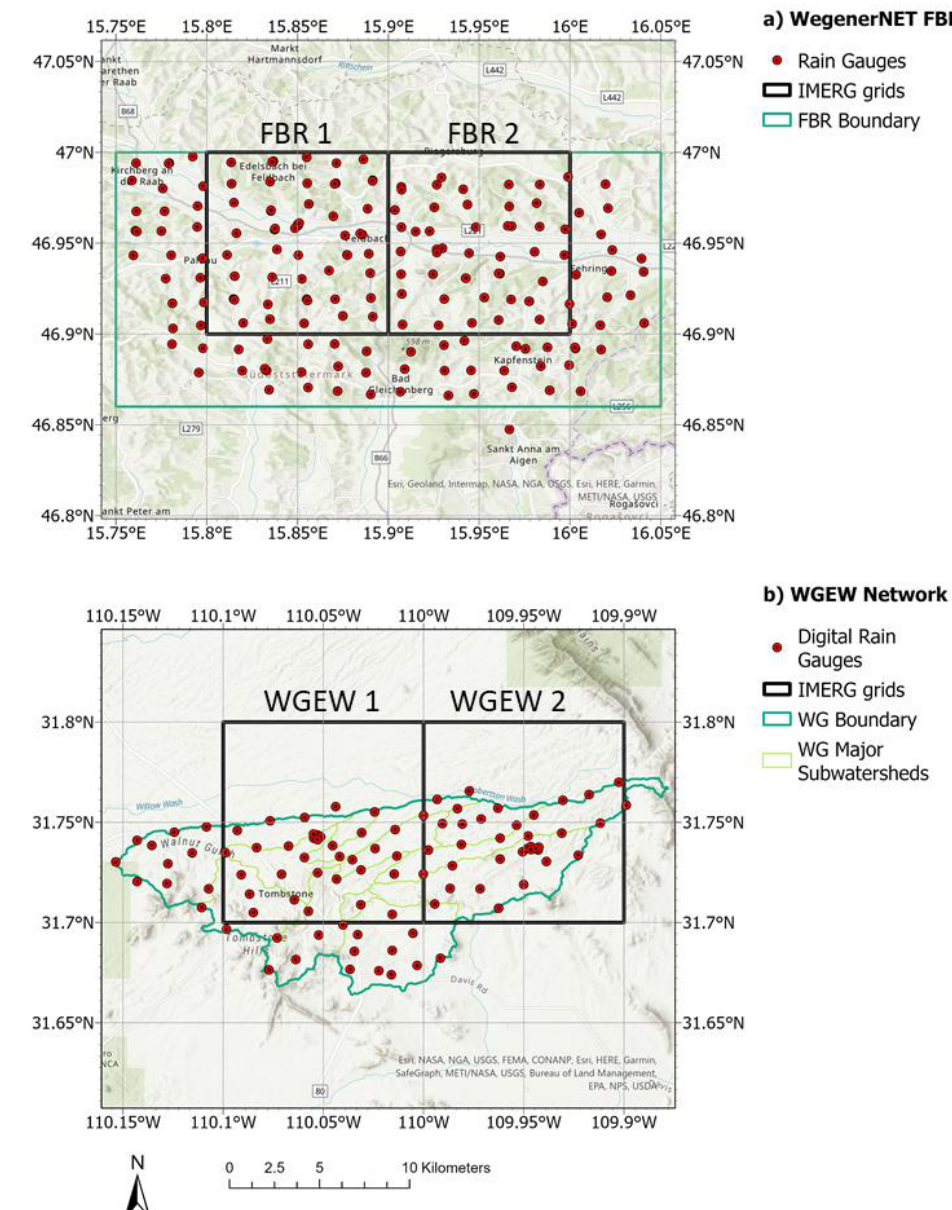
Figure 1. Maps of the study areas: ( a ) WegenerNet Feldbach Region (FBR) network, Austria, and ( b ) Walnut Gulch Experimental Watershed (WGEW), Arizona. The black boxes are the IMERG grids.